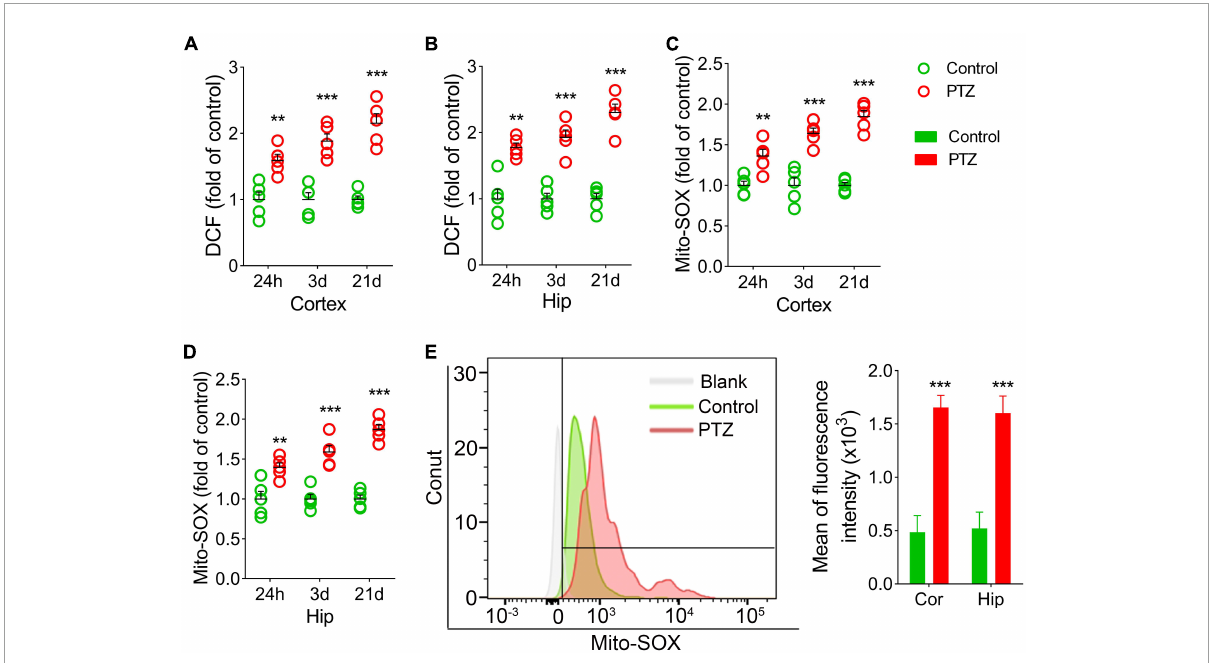
FIGURE3 Increased 2’,7’-dichlorodihydrofluorescein (DCF) and mito-SOX levels during pentylenetetrazole (PTZ)-induced epileptogenesis. Increased DCF (A,B) and mito-SOX (C,D) levels in the hippocampus and cortex during epileptogenesis ( n = 5/group). (E) Flow cytometry-based quantification of mito-SOX levels. ** P < 0.01 and *** P < 0.001, compared with controls (unpaired T -tests).